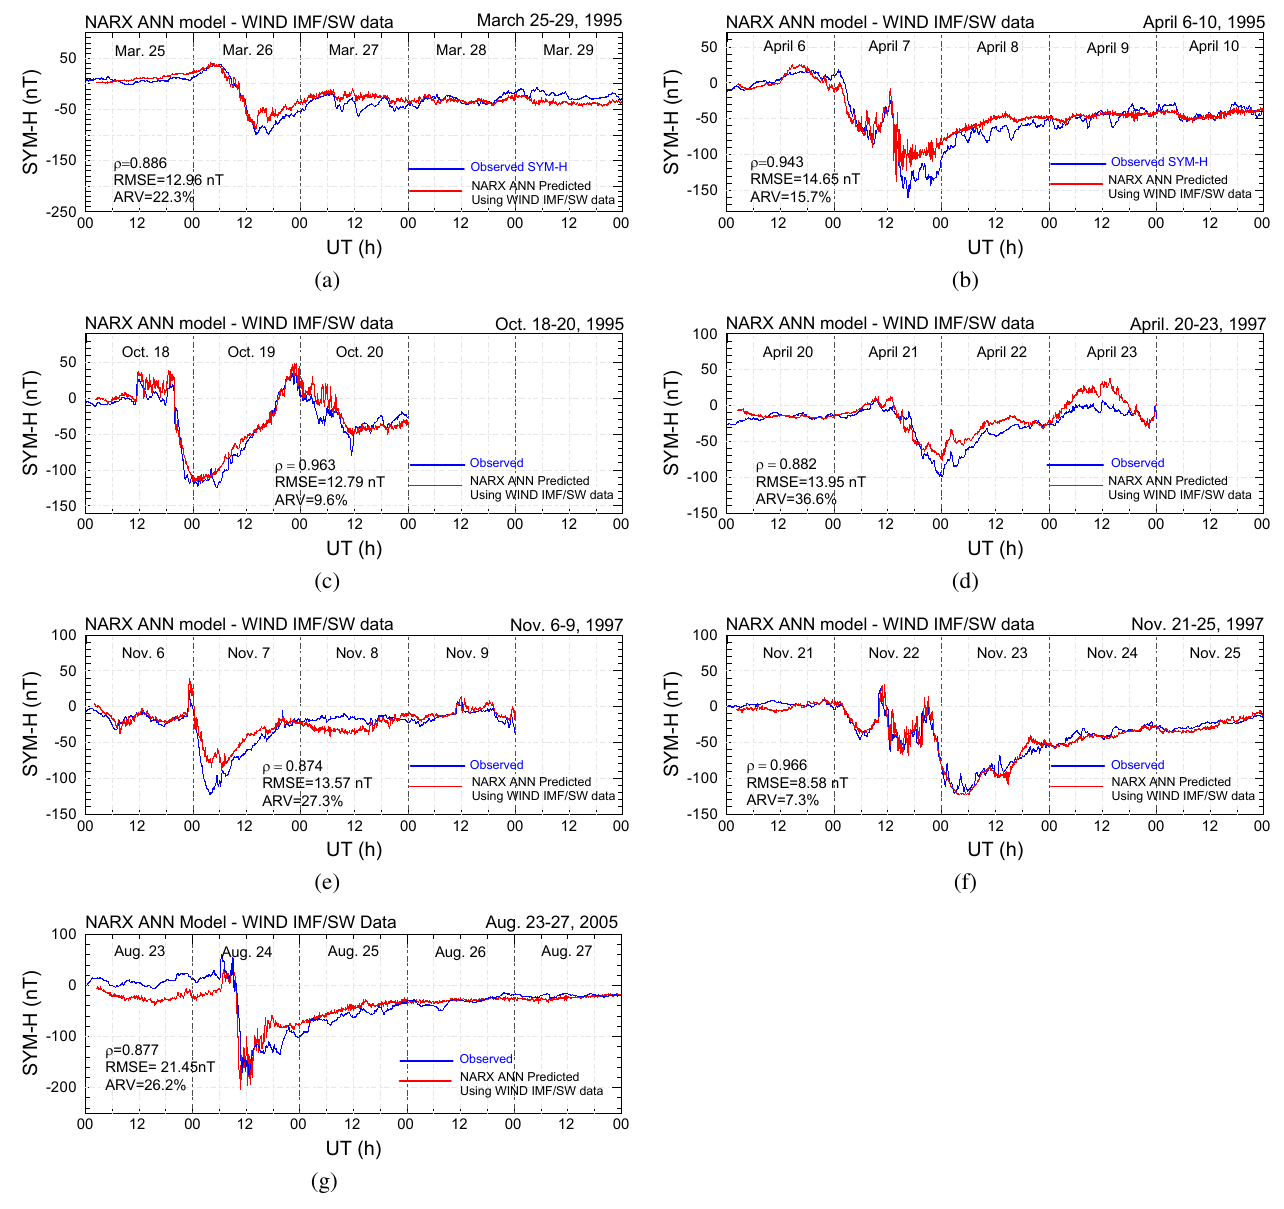
Fig. 7. Comparison of observed SYM-H index with that predicted by NARX neural network with 24 context units for each testing storm event whose IMF/SW data are from WIND. as a whole increased up to: ρ = 0 . 86, RMSE = 26 . 2 nT, ARV = 26 . 2%, which is still not better than NARX model ( ρ = 0 . 95, RMSE = 17 . 1 nT, ARV = 10 . 7%). Besides, longer input time length degraded greatly the applicability when only short time qualified IMF/SW data are available (see Fig. 9e).